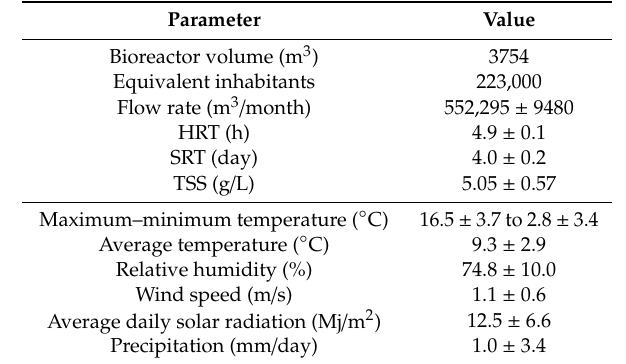
Table 1. Main operational and environmental parameters of the Los Vados wastewater treatment plants (WWTP). Data were provided by the municipal wastewater company of Granada (Emasagra S.A.). HRT: hydraulic retention time; SRT: sludge retention time; TSS: total suspended solids.